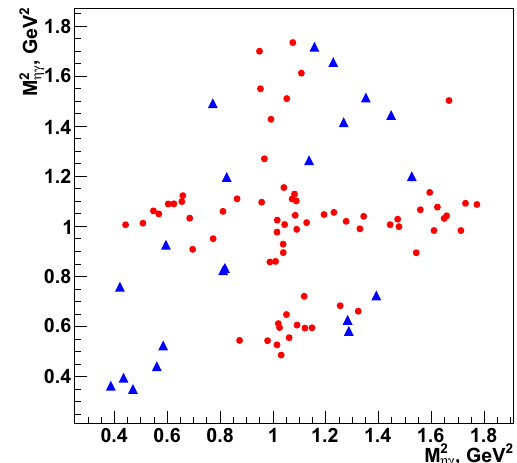
Fig. 3 The scatter plot of the two ηγ invariant mass squared combina- √ s = 1 . 57–2.00GeVselectedwiththecondi- tionsfordataeventswith < 10.Eventsthatsatisfythecondition χ 2 tion χ 2 ηηγ − χ 2 5 γ are marked by blue triangles